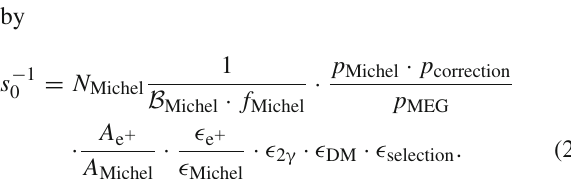
The number of MEx2G events is given